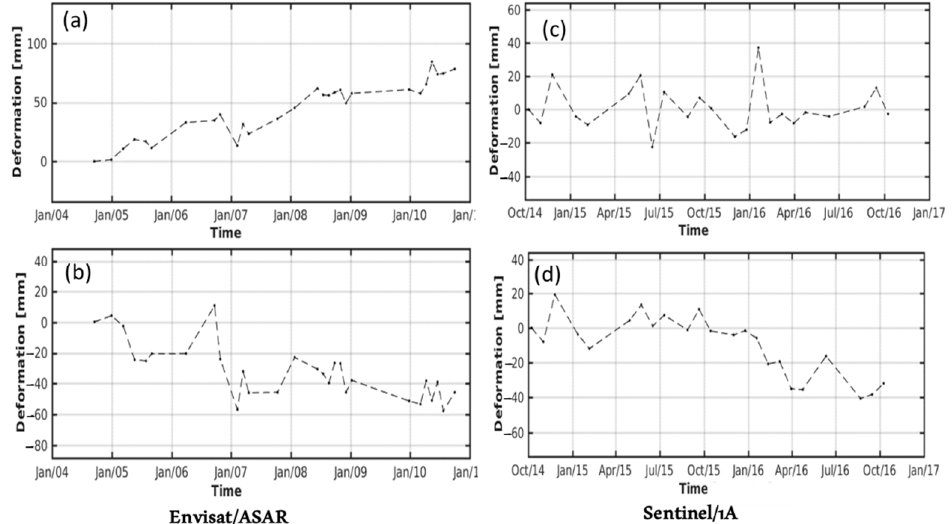
Figure 6. Time series of vertical ground displacement for the selected representative points ( a – d ) mapped in Figure 3. ( a ) Represents the location undergoing uplift near the Mangopir Hills in West Karachi; ( b , d ) mark the subsiding location in the area where water tanker collapsed in the DHA in South Karachi; whereas ( c ) represents a relatively stable location between the Haji Khoast Fault and Sona Pass fault in West Karachi.